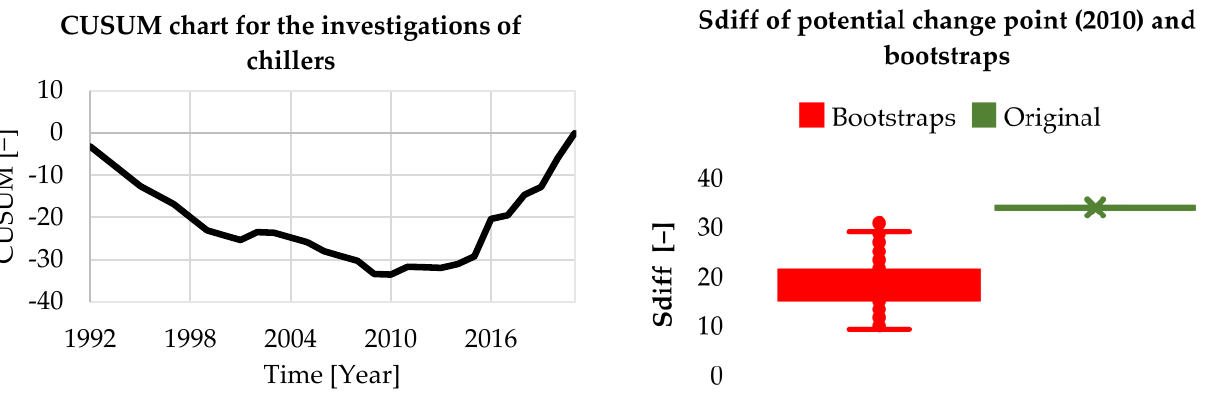
Figure 16. CUSUM chart for investigations of chillers (on the left ) and the Sdiff boxplot for the changepoint and the bootstraps (on the right ) for CCS articles.